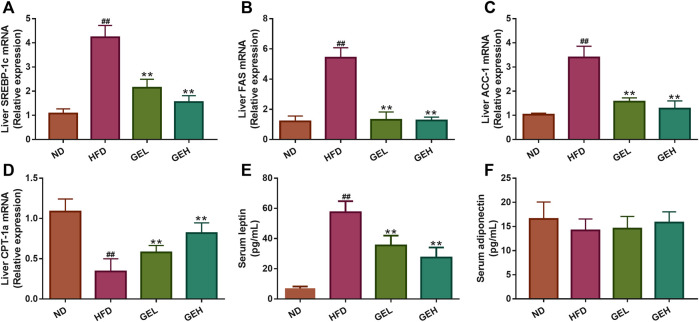
Effects of GE treatment on hepatic gene expression and serum hormones involved in lipid metabolism. (A–C) The mRNA relative expression of adipolytic genes in the liver. (D) The mRNA relative expression of adipogenic gene in the liver. (E–F) The levels of serum leptin and adiponectin. n = 8 per group. #
p <0.05 or ##
p <0.01 vs. the ND group. *p <0.05 or **p <0.01 vs. the HFD group.